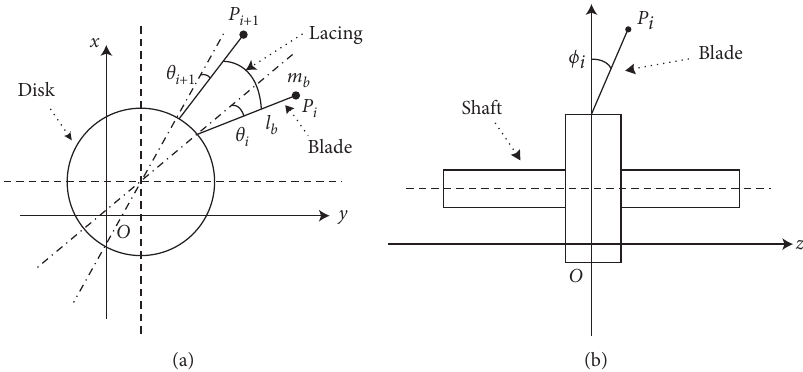
Figure 1: Model of the position of i -th blade. (a) In-plane deflection of blade. (b) Out-of-plane